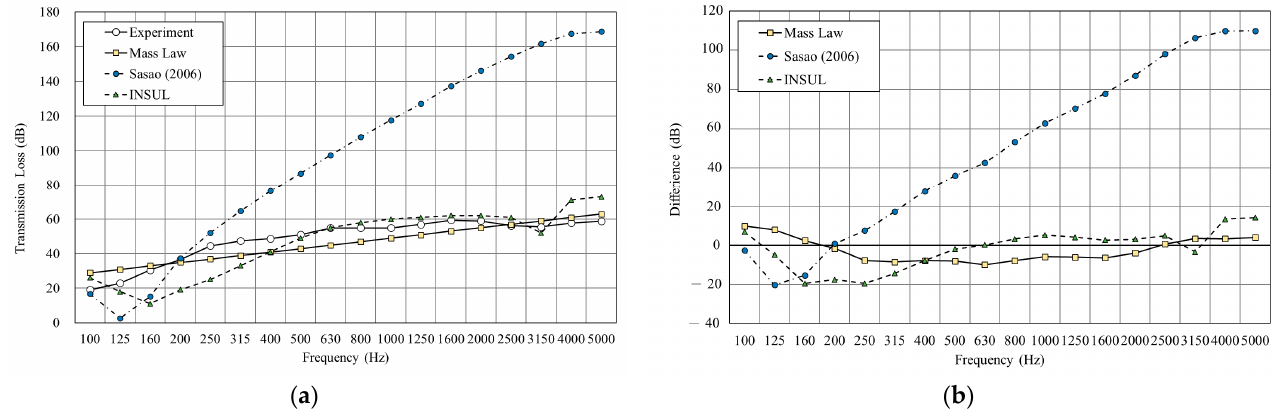
Figure 17. Comparison between experimental and predicted results of CLT + GB with 25 mm cavity (C1). ( a ) The sound insulation performance of experiment and prediction. ( b ) The RMSE results of different prediction models.